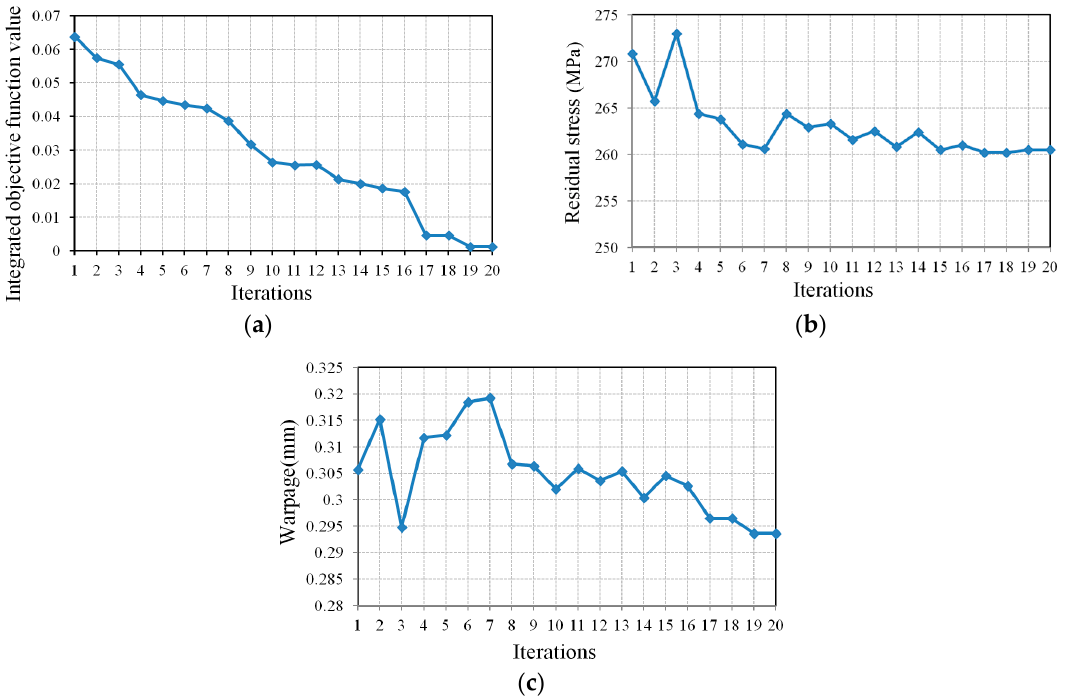
Figure 7. Optimization iterative process. ( a ) Relationship between integrated objective function value and iterations; ( b ) Relationship between residual stress and iterations; ( c ) Relationship between warpage and iterations.